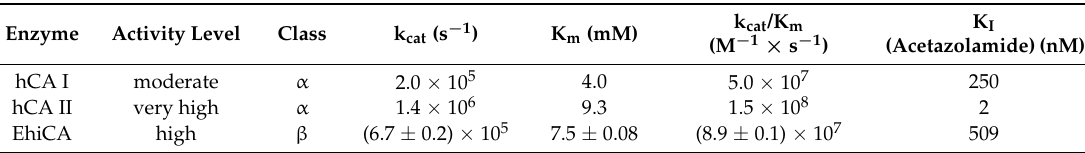
Table 1. Kinetic parameters for the CO 2 hydration reaction catalyzed by the human cytosolic isozymes hCA I and II ( α -class CAs) at 20 ◦ C and pH 7.5 in 10 mM HEPES buffer and 20 mM Na 2 SO 4 , and the β -CA EhiCA form E. histolytica measured at 20 ◦ C, pH 8.3 in 20 mM TRIS buffer and 20 mM NaClO 4 . Inhibition data with the clinically used sulfonamide acetazolamide (5-acetamido-1,3,4-thiadiazole-2-sulfonamide) are also provided